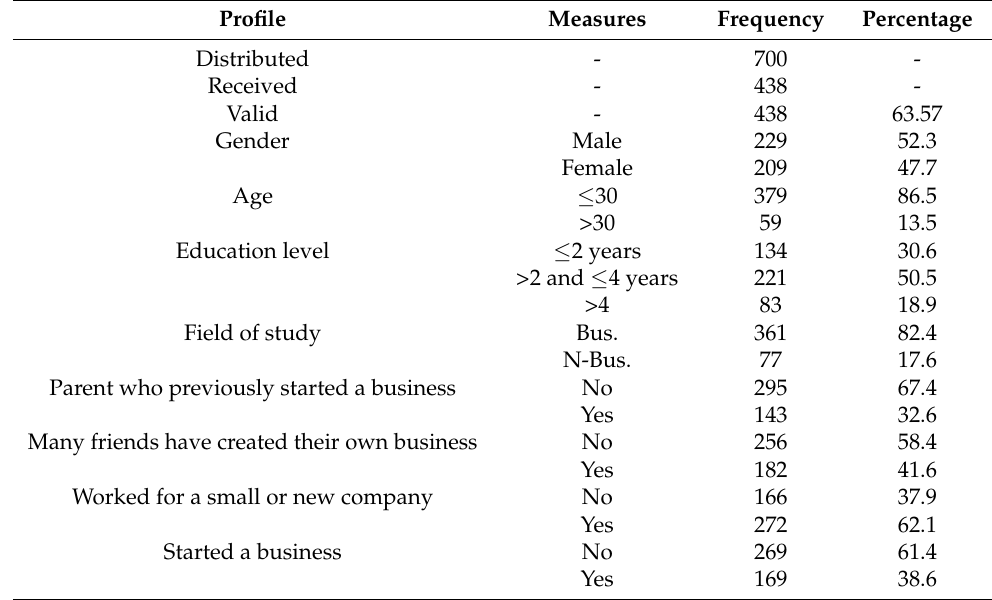
Table 1. Description of the